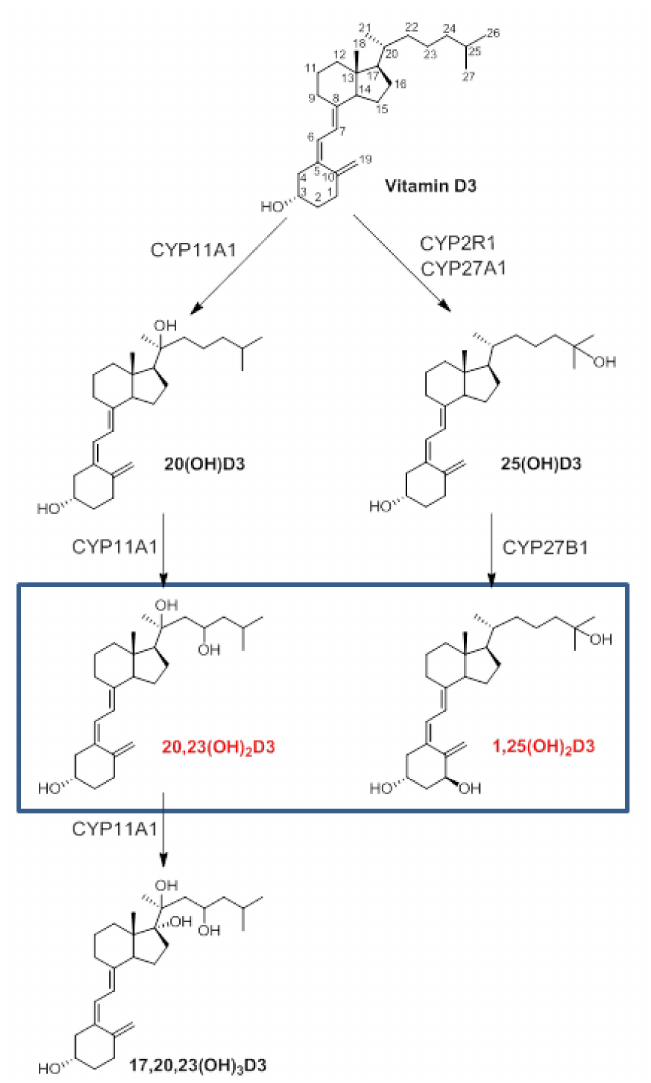
Figure 1. Epidermal pathways of vitamin D3 activation to produce 1,25(OH) 2 D3 and 20,23(OH) 2 D3 and the downstream metabolite 17,20,23(OH) 3 D3. The rectangle marks the secosteroids used for microarray